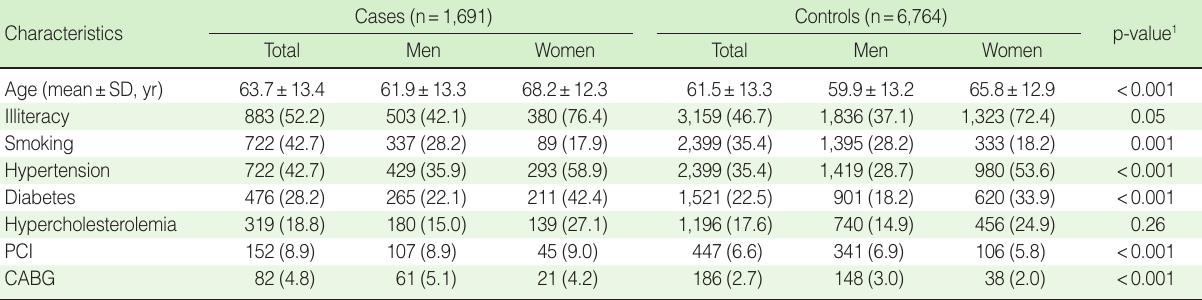
Table 1. Comparison of the demographic characteristics and medical history at baseline (the date at heart failure diagnosis) in cases and controls, adjusted for gender